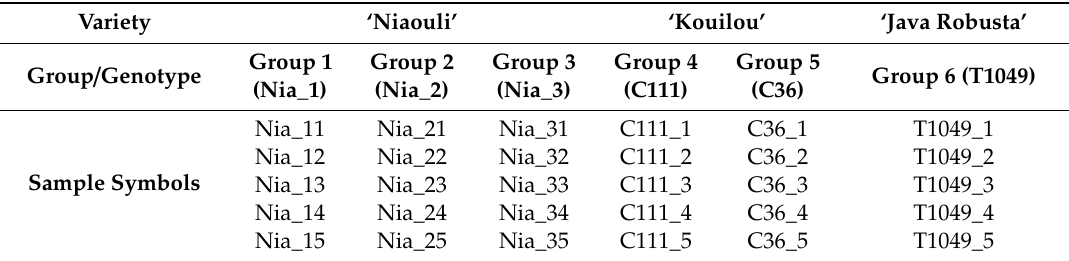
Table 5. Sample genotypes and symbols.